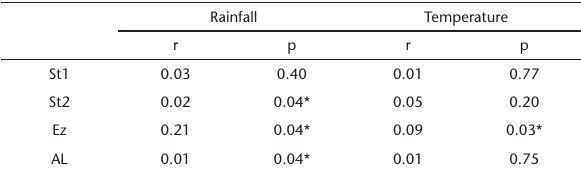
Table 2. Relations between the density of primary spermatocytes (St1), secondary spermatocytes (St2), sperm (Ez) and the area occupied by the seminiferous locules (LA) in male Leptodactylus macrosternum species in relation to rainfall and temperature in the Horto Florestal Olhod’Água da Bica (HFOB) area in the municipality of Cuité, state of Paraíba, Brazil, in the periods from May to August and November to December 2013. * = Represents significant